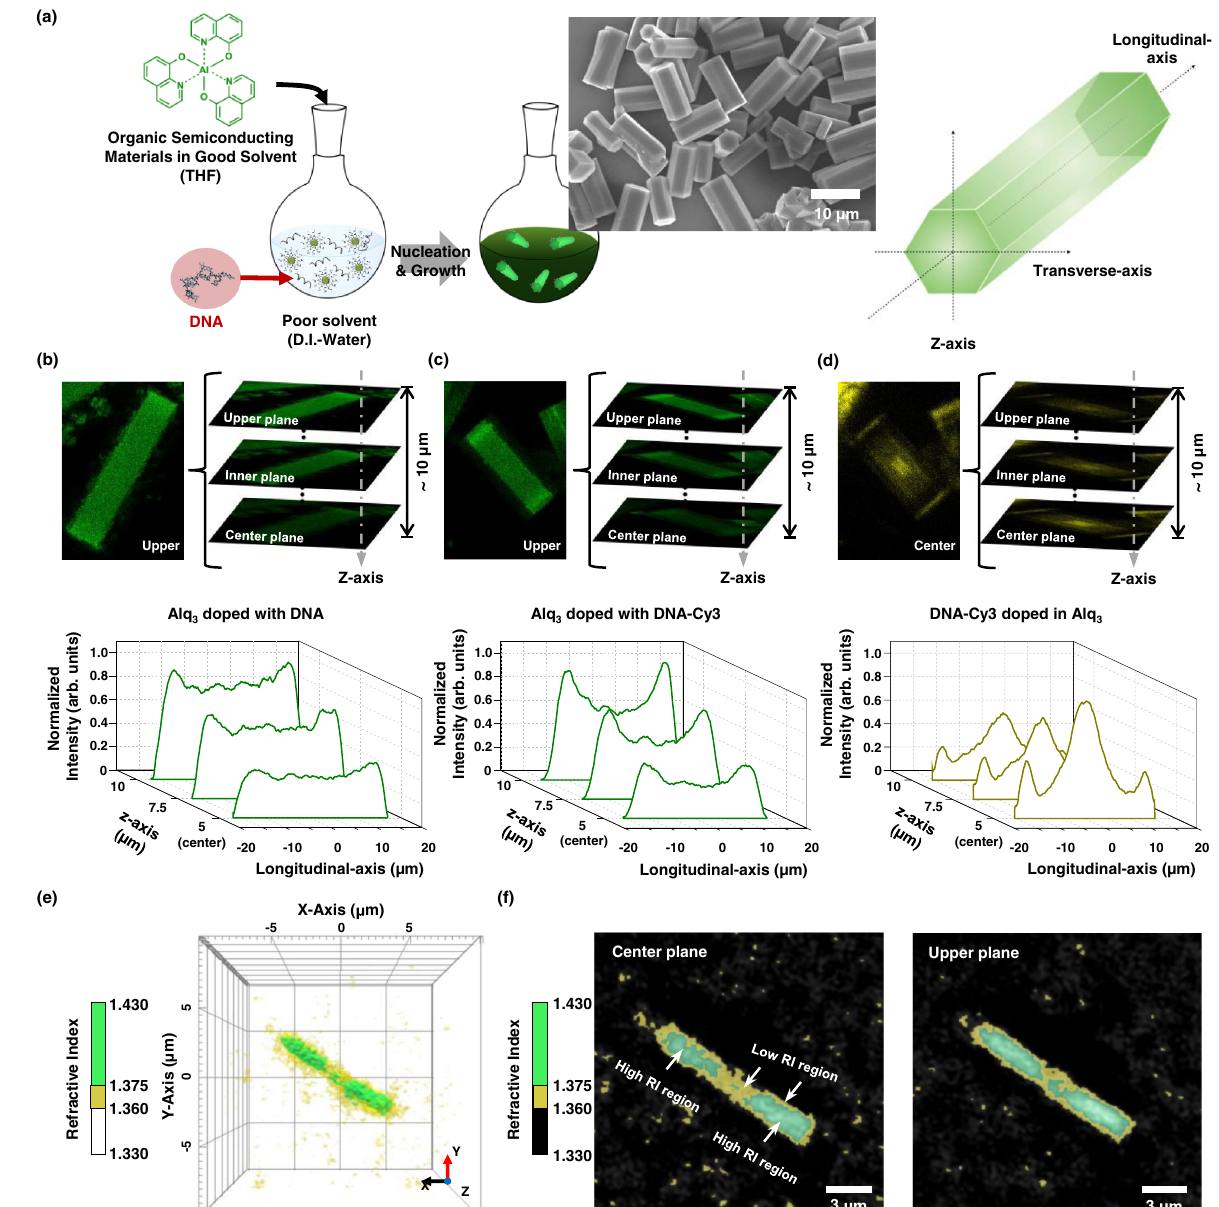
Fig. 1 | DNA as a molecular dopant in light-emitting organic crystals. a Schematic illustration of the fabrication of DNA-doped Alq 3 microparticles (left) and de fi nition of coordination of hexagonal microrods (right). Z-stack confocal laser scanning microscopy images (top) and longitudinal normalized fl uorescence pro fi les averaged from fi ve separate particles from the upper to the center plane (bottom)of( b )DNAdopedAlq 3 molecules,( c )DNA-Cy3dopedAlq 3 molecules,and ( d ) DNA-Cy3 molecules in a particle. The single-stranded DNA sequence for fabri- cating the particles is 5 ′ -ATC CTT ATC AAT ATT TAA CAA TAA TCC-3 ′ . The images and pro fi les of Alq 3 molecules are obtained by excitation using a 405nm laser; a 300 ‒ 550nm fi lter is used. The images of the DNA-Cy3 molecules are obtained by excitation with a 555nm laser; a 300 ‒ 630nm fi lter is used. The fl uorescence of